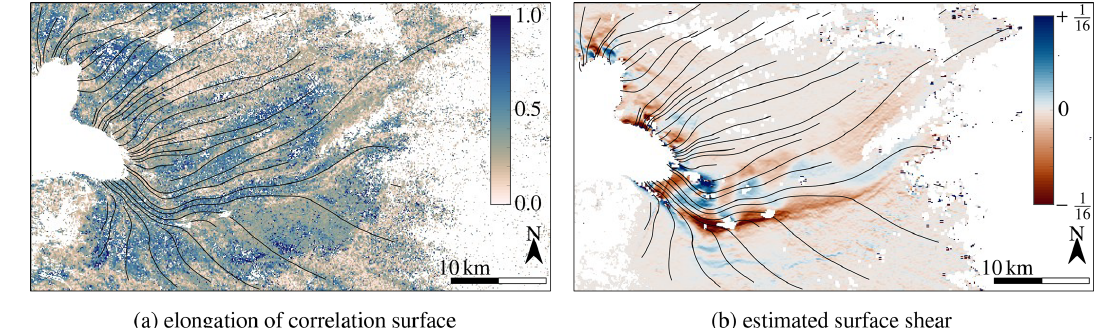
Figure 4. The strength of asymmetry of the correlation peak (a) and estimated surface shear (b) .